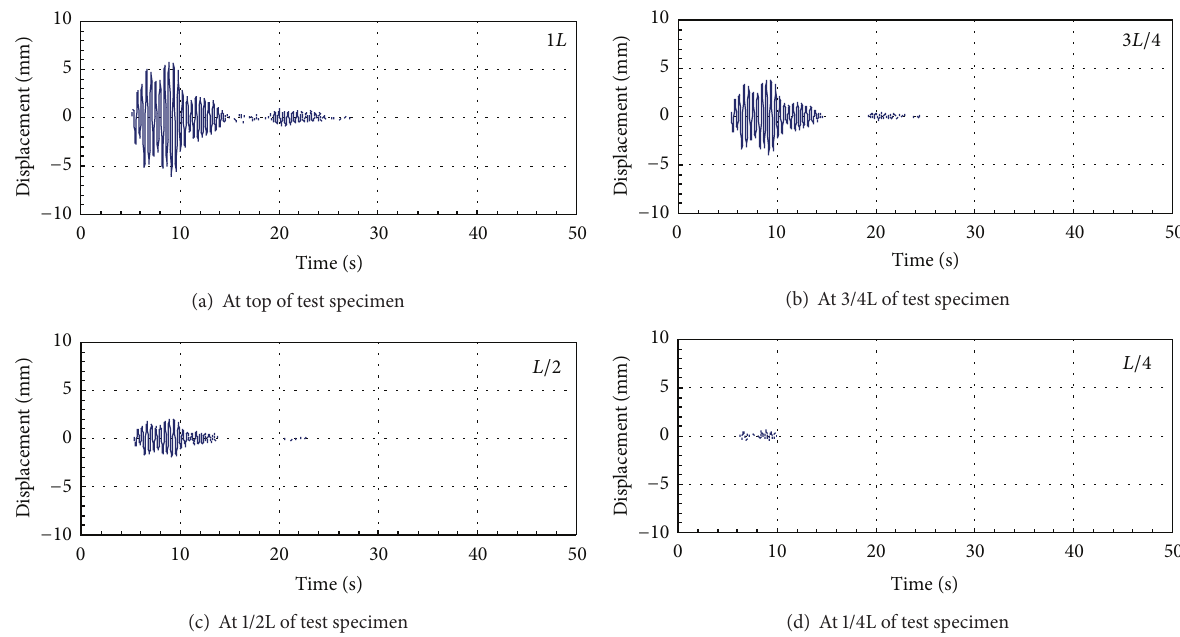
Figure 10: The time history of displacement response of test specimen under excitation of Kobe earthquake at top, 3/4𝐿 , 1/2𝐿 , and 1/4𝐿